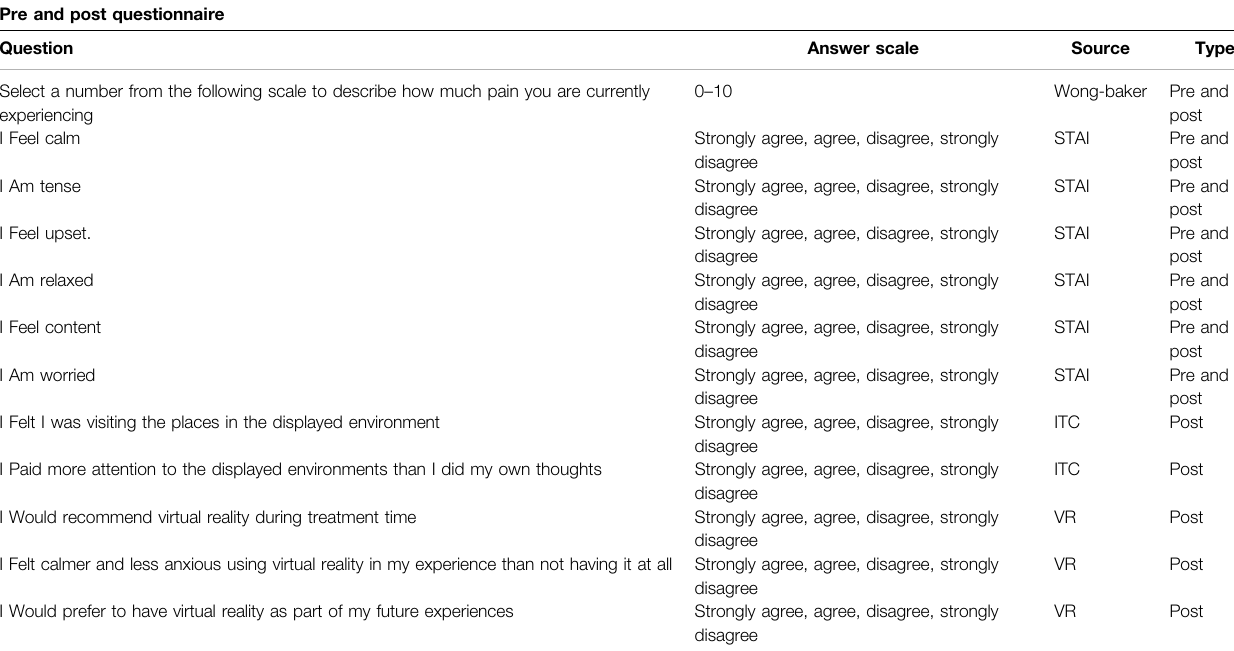
TABLE 1 | Pre and post